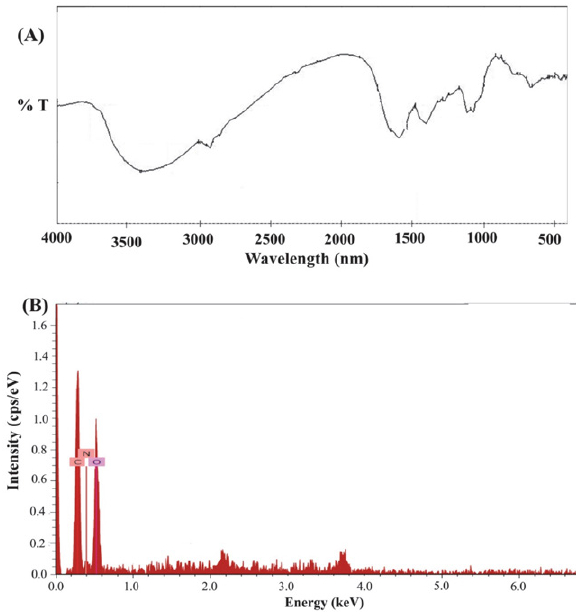
Figure 1: A) N-GQDs in Visible Light, (B) N-GQDs excited in UV light wavelength 254 nm, (C) N-GQDs excited in UV light wave- length 365 nm, (D) UV-Visible spectra of N-GQDs